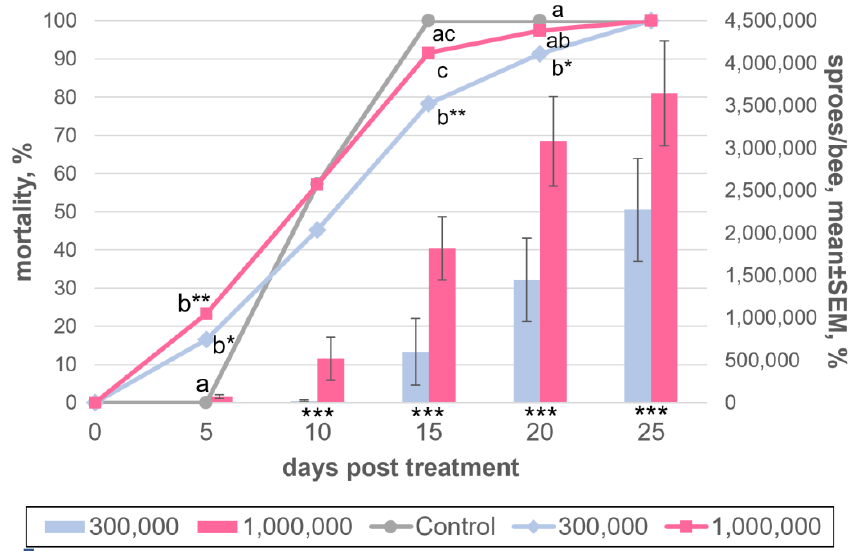
Figure 2. Dynamics of Vairimorpha ceranae development in adult honey bees experimentally infected with either 0.3 (“300,000”) or 1 million spores/bee (“1,000,000”) and maintained at 25 ◦ C. Spores were isolated from dried honey bee cadavers stored at room temperature. The curves show cumulative insect mortality, and different letters indicate statistically significant differences at a given time point at p < 0.05 (*) or p < 0.01 (**), estimated using Pearson’s chi-square. Higher probability data are not indicated for clarity. The bars show the mean spore production, calculated as the ratio of the total number of spores observed in cadavers to the total number of bees that perished up to a given time point. The asterisks below bars indicate pairs of values that are significantly different from each other at p < 0.01 (**) or p < 0.001 (***) at a given time point, as inferred from the Kruskal–Wallis one-way analysis of variance on ranks and Mann–Whitney rank sum tests. The data which this scheme was created from are found in Table S1.